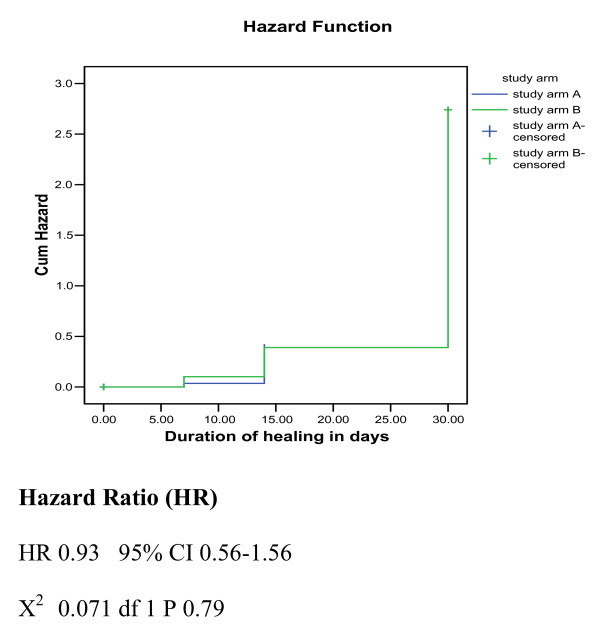
Hazard Function.